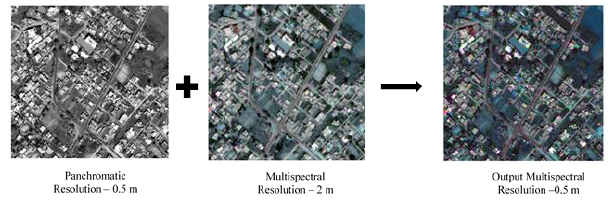
Figure 2 Worldview Data sets used for